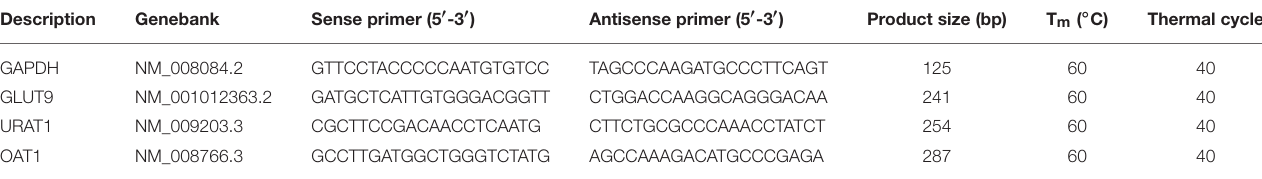
TABLE 1 | PCR primer sequences and protocols.